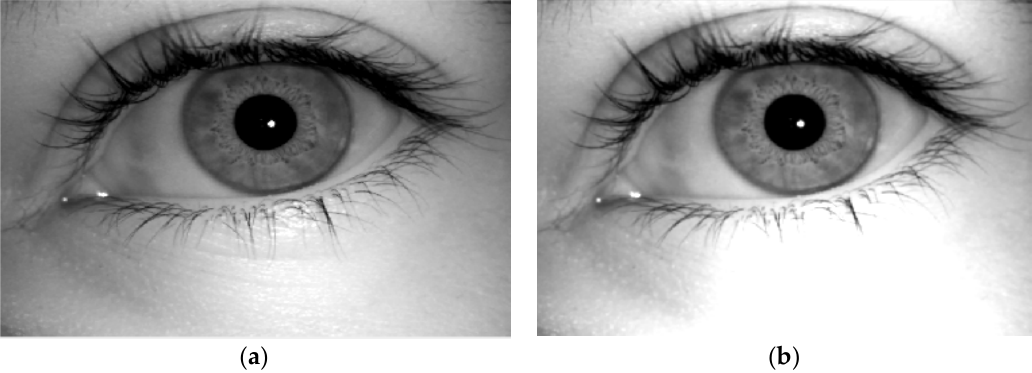
Figure 2. ( a ) Original Image. ( b ) Output of weighted average filter image.